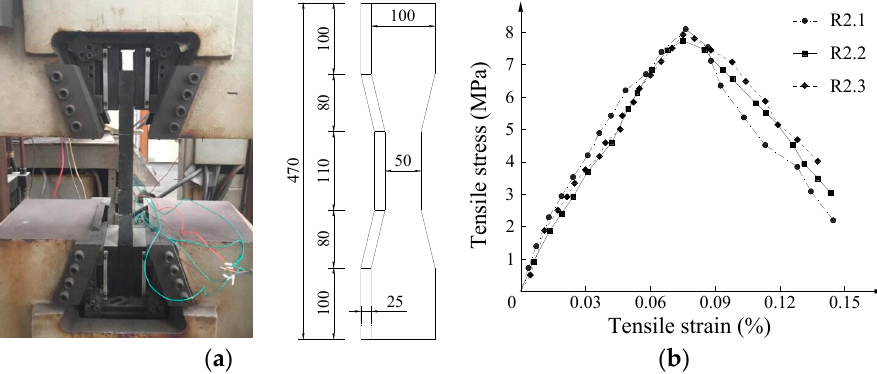
Figure 3. Tensile test of resin concrete: ( a ) Setup and dogbone specimen (mm), ( b ) stress-strain relationship.